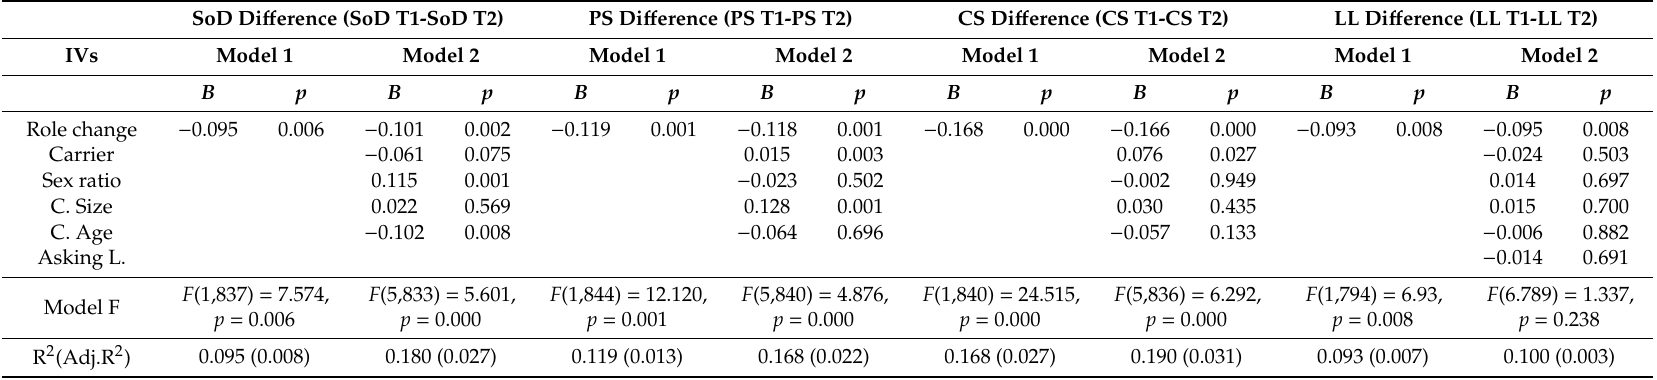
Table 8. Hierarchical regression for predicting SoD, PS, CS, and LL di ff erences, including class variables, and a method for investigating LM and LL (Group 4: No-role